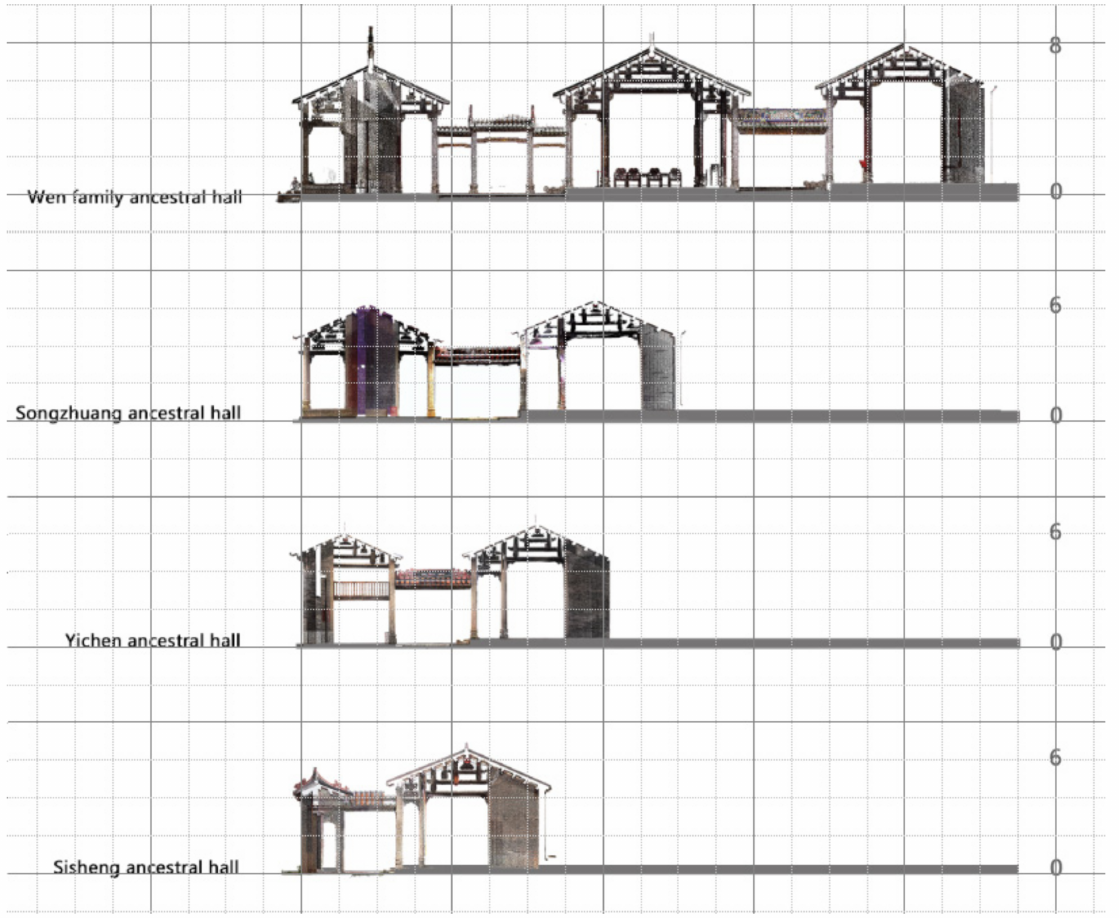
Figure 10. Comparison of four ancestral halls by height. From top to bottom, these four buildings are Wen Family Ancestral Hall, Songzhuang Ancestral Hall, Yichen Ancestral Hall, and Sisheng Ancestral